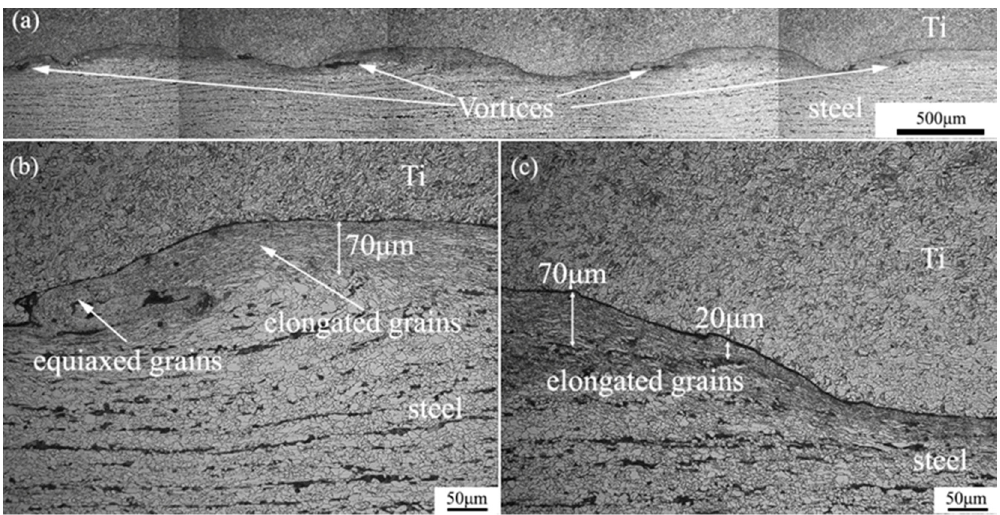
Figure 3. Optical images of the interface in the TA1 / LAS composite plate: ( a ) an overview image, ( b ) magnified image of the typical wave crest microstructure, ( c ) magnified image of the typical wave trough microstructure.